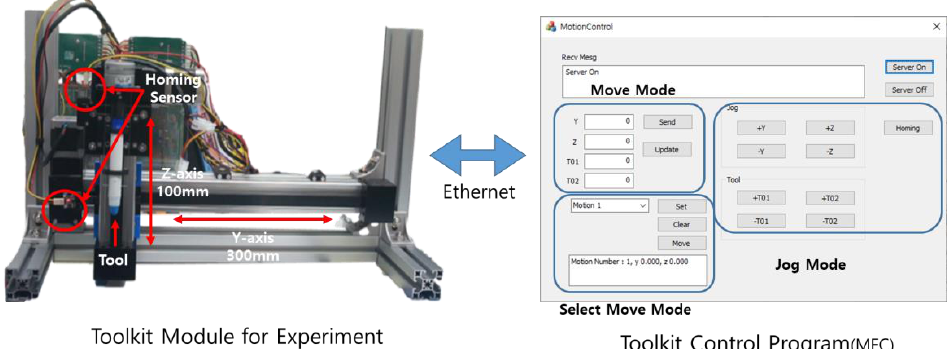
Figure 7. Toolkit Module for the Experimental